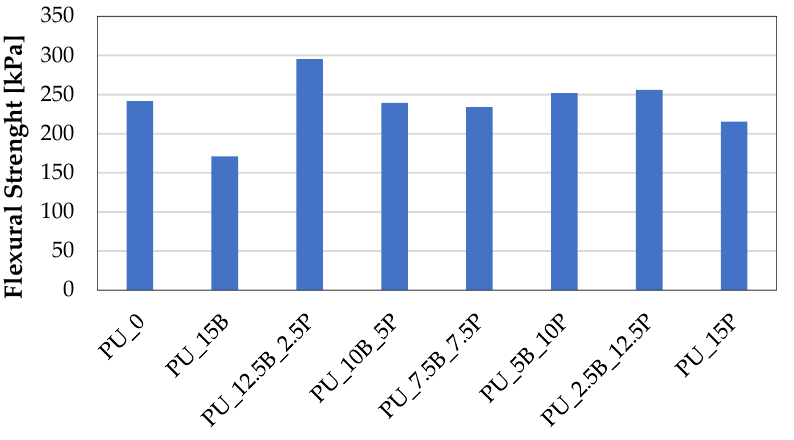
Figure 6. Flexural strength of rigid PU foams containing buckwheat hulls and perlite.